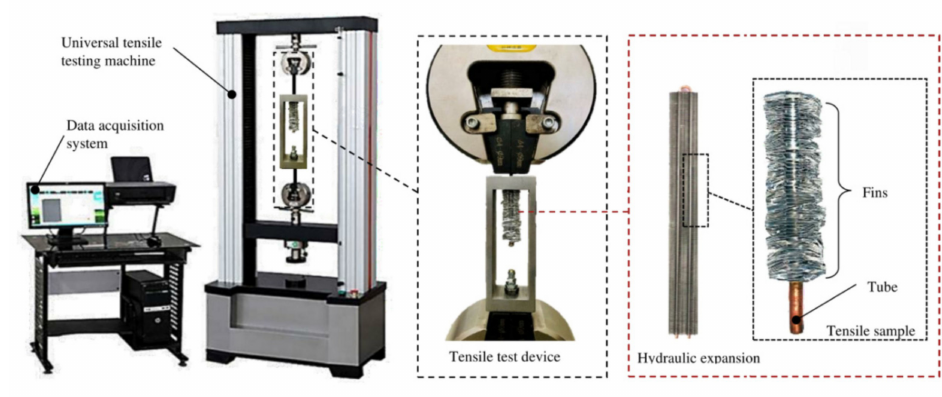
Figure 7. Tensile test platform.